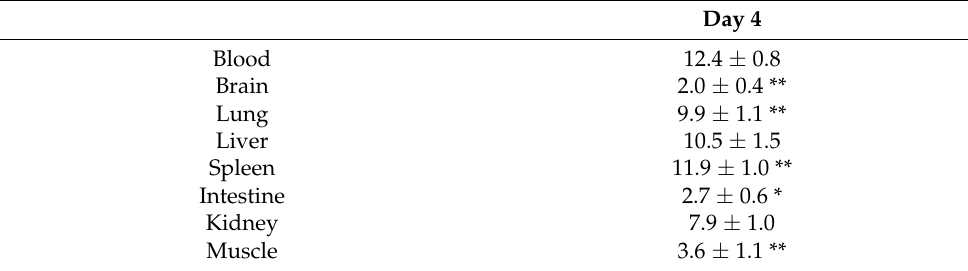
Table 2. Biodistribution of 225 Ac-labeled NZ-16 in H226 tumor-bearing mice.